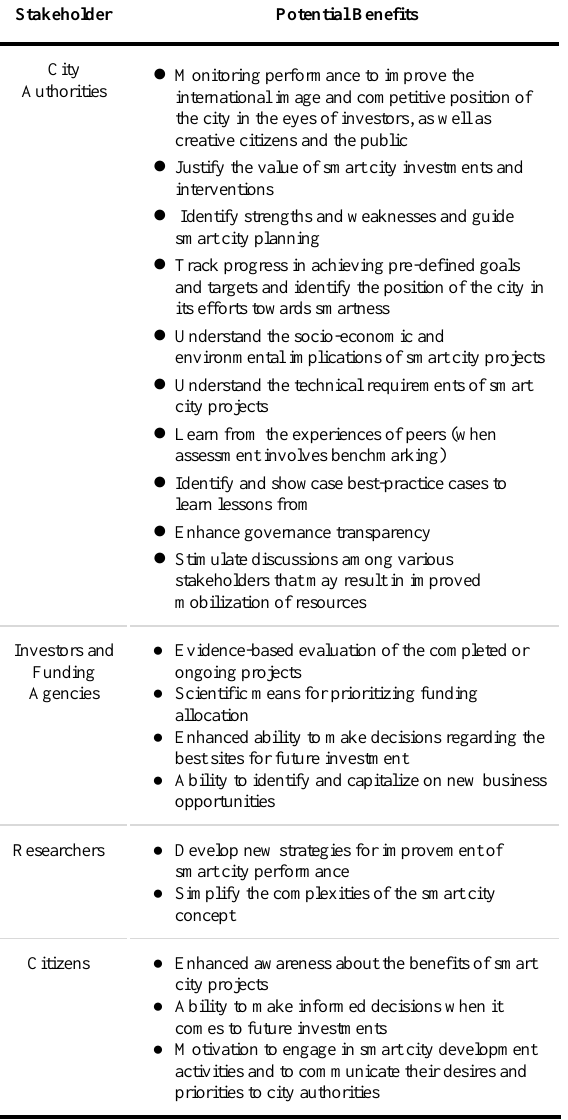
Table 4. Potential multiple benefits of Smart City Assessment for different stakeholders by Sharifi (2019)